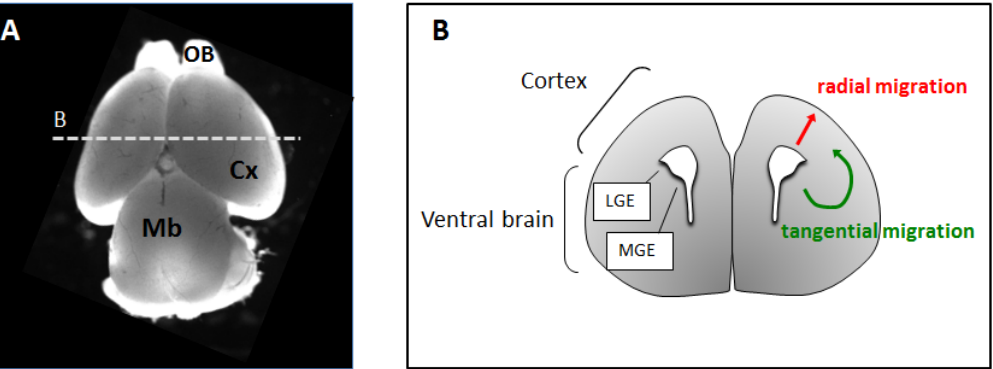
Figure 1. ( A ) Top view of a mouse brain at embryonic stage E15.5. OB: olfactory bulb, Cx: Cortex; Mb: Midbrain. ( B ) Schematic representation of a coronal section of a mouse embryonic brain through the plane B. Routes of radial and tangential neuronal migration are shown in red and green, respectively. LGE: lateral ganglionic eminence; MGE: medial ganglionic eminence